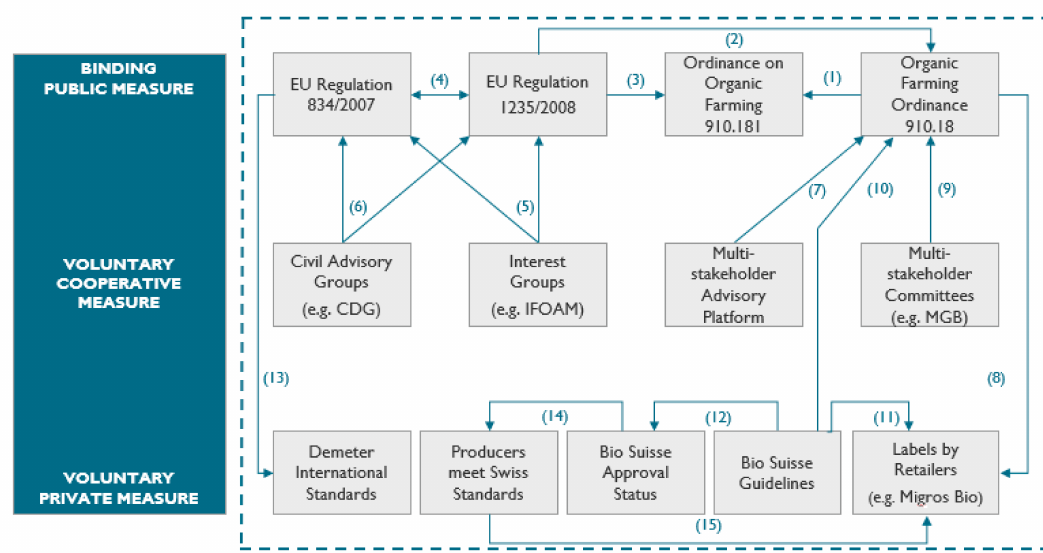
Figure 2. Selected key measures in the organic sector and their